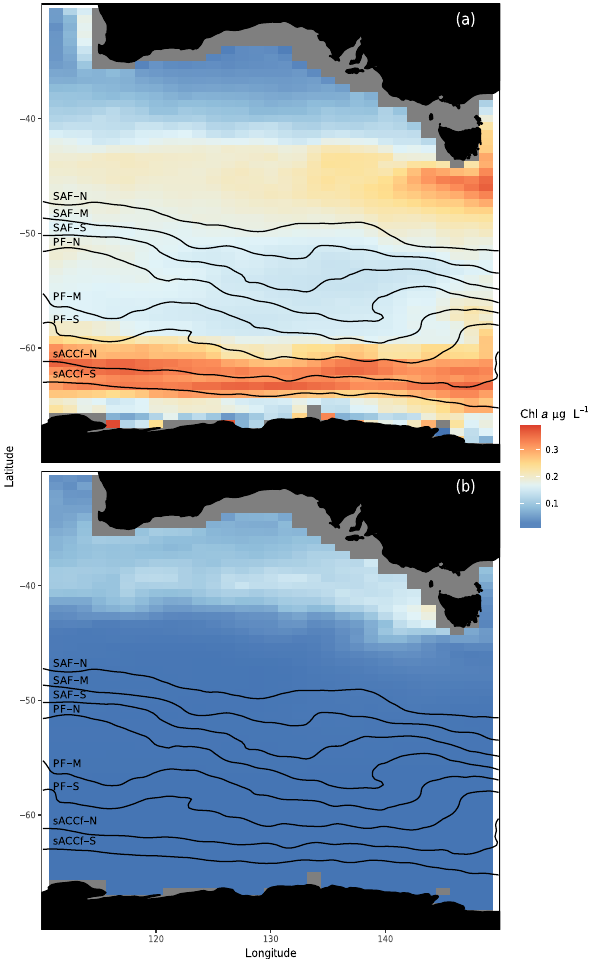
Figure 8. Maps of NASA Ocean Biogeochemical Model results for (a) diatom and (b) coccolithophore distribution. Results are means for productive months (October–March for 2008–2012, 2012 being the last year available